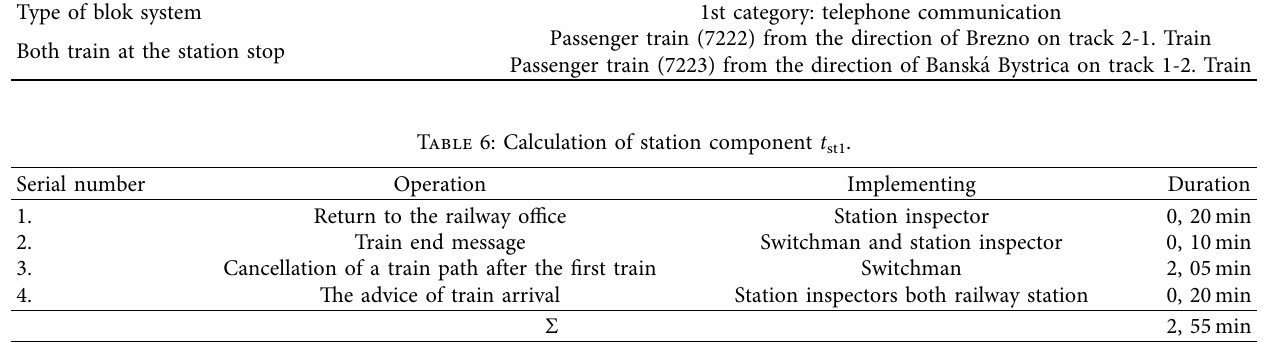
Table 7: Calculation of station component t